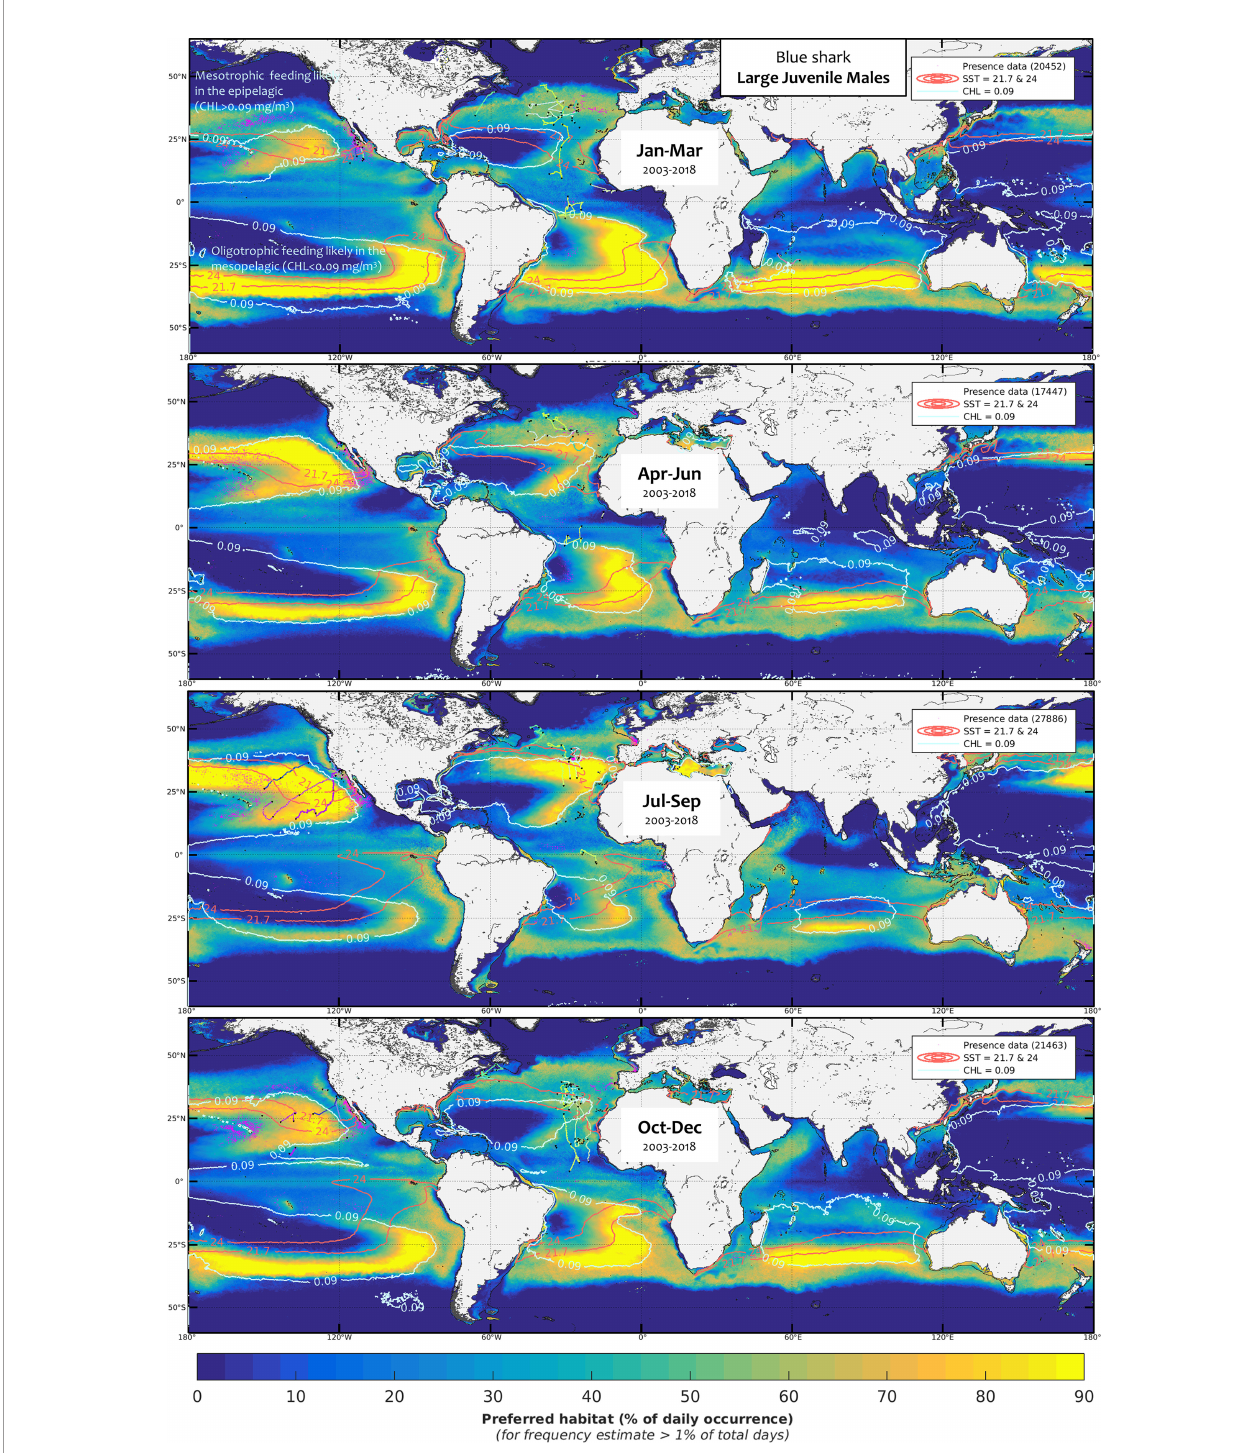
FIGURE 7 | Mean seasonal distribution of blue shark foraging habitat for the large juvenile males (LJM, 2003-2018, in frequency of suitable habitat occurrence, %). The chlorophyll-a isocontour of 0.09 mg.m -3 ( CHL min ) separates the mean area of oligotrophic foraging (below this value using mesopelagic micronekton as foraging proxy) and mesotrophic foraging (above this value using productivity fronts). Presence data (calibration and validation) are represented as pink dots for observer data and colored line transects for electronic tagging data (start and end of months are shown by a black star). The SST isocontours of LJF avoidance (21.7°C and 24°C), slightly larger than for AF, allow evaluating the potential lack of habitat overlap with